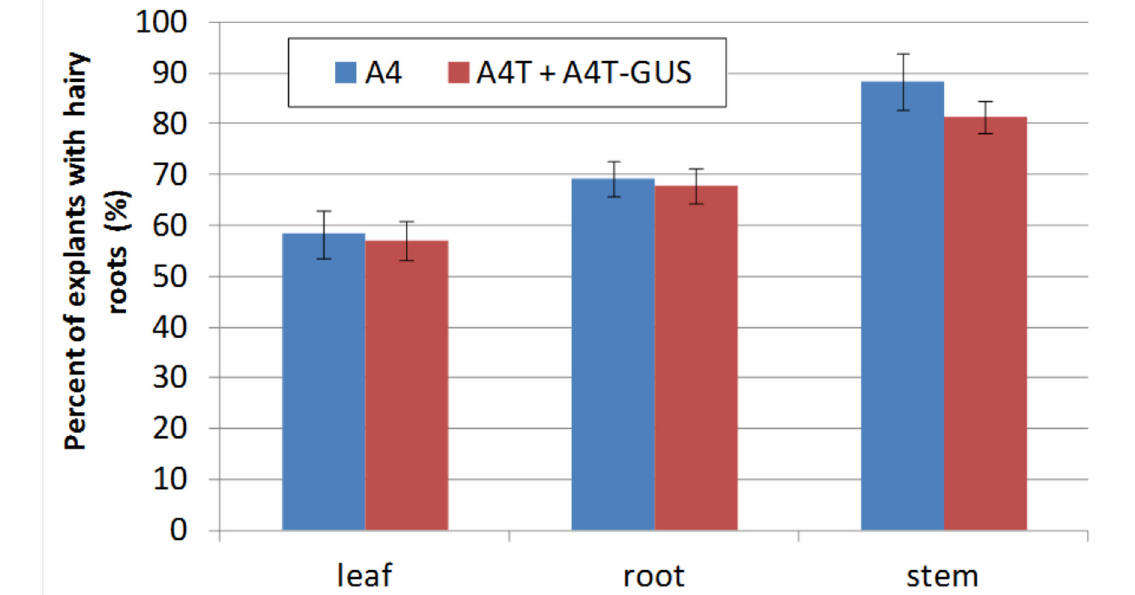
FIGURE 3 - Effectiveness of the A4 and A4T strains in the induction of hairy root development on H. sinaicum explants exposed to a solid MS medium. A4T - combined data for explants inoculated with the A4T and A4T-GUS strains. Whiskers - standard